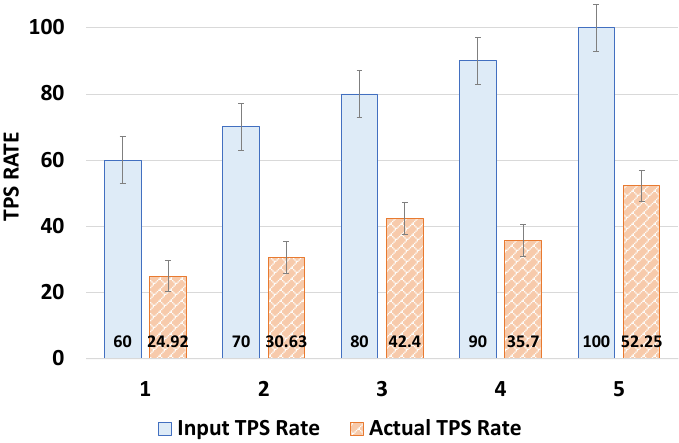
Figure 6. Performance on TPS.